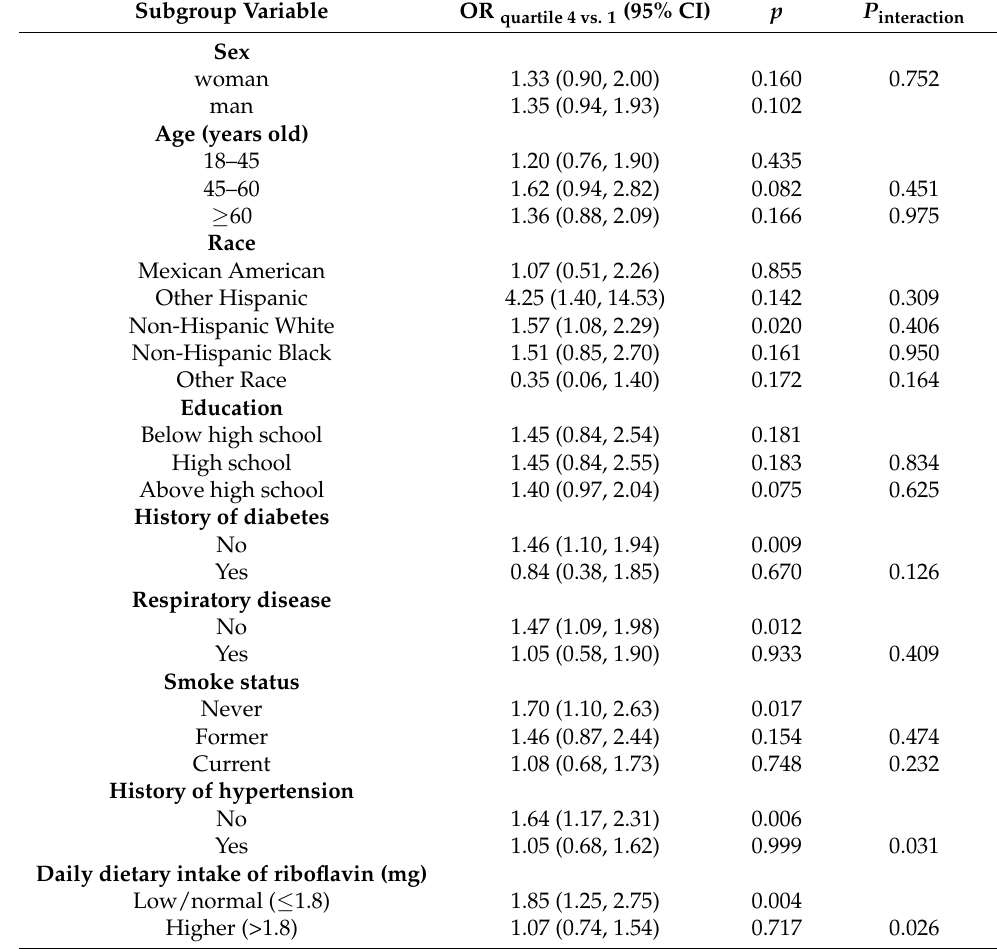
Table 4. Subgroup analyses on the association between urinary MBP and lung function